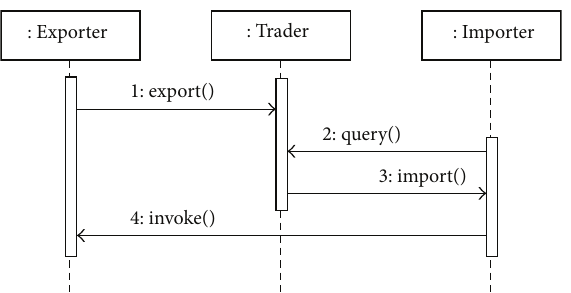
geographic ontology based on Geographic Markup Language (GML) [34], and the OWL-S profile is extended to geographic Web for Earth and Environmental Terminology